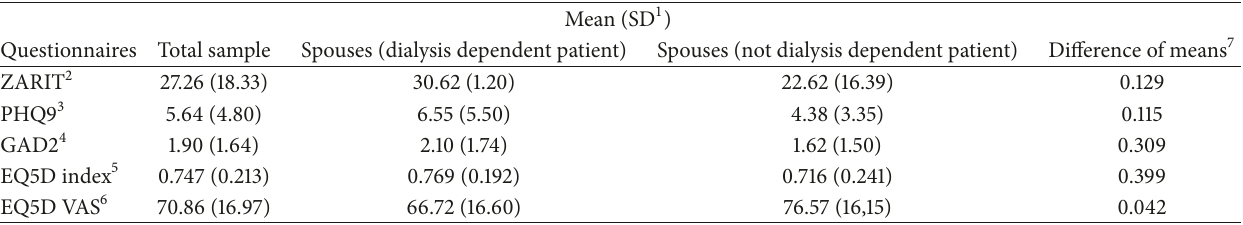
Table 2: Spouses’ mean scores (SD) on burden, depression, anxiety, and quality of life questionnaires in two groups. Mean (SD 1 ) Questionnaires Total